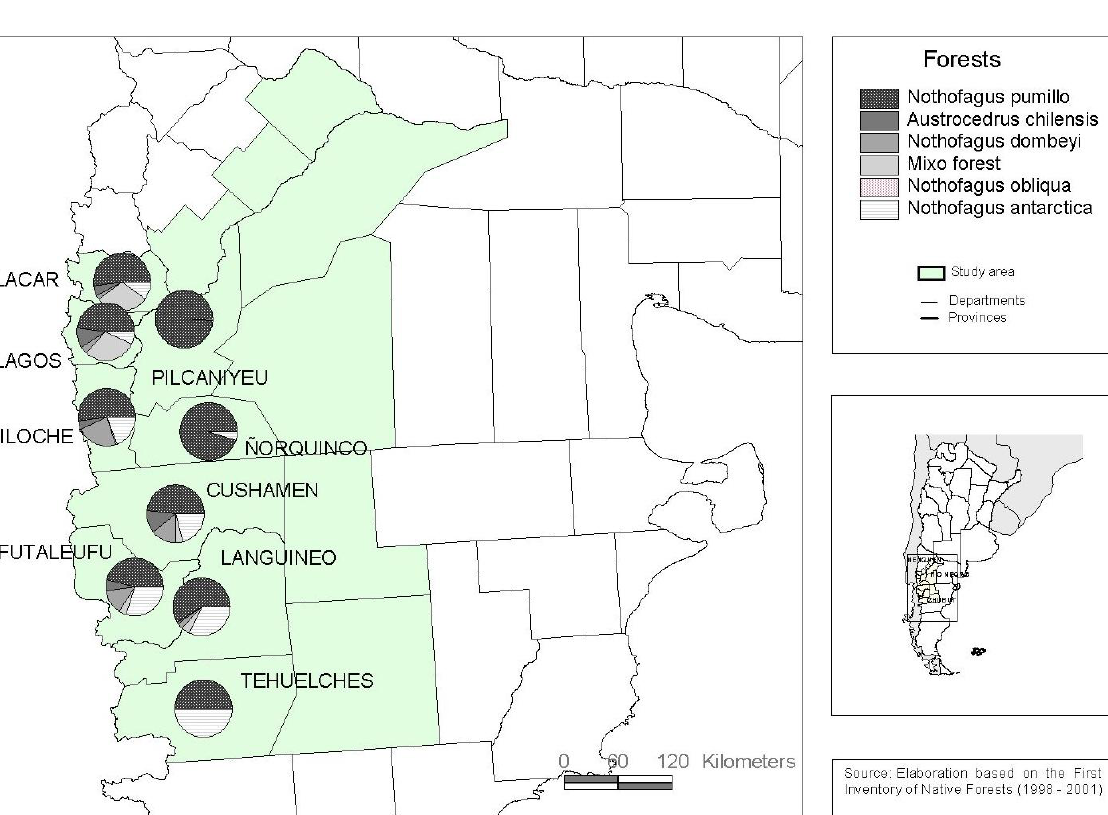
Figure 7. Distribution of native forests [Realized by the